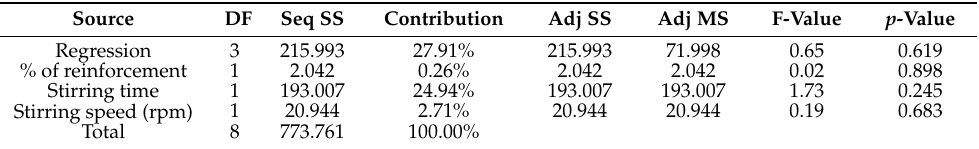
Table 9. Analysis of variance for ultimate tensile strength.